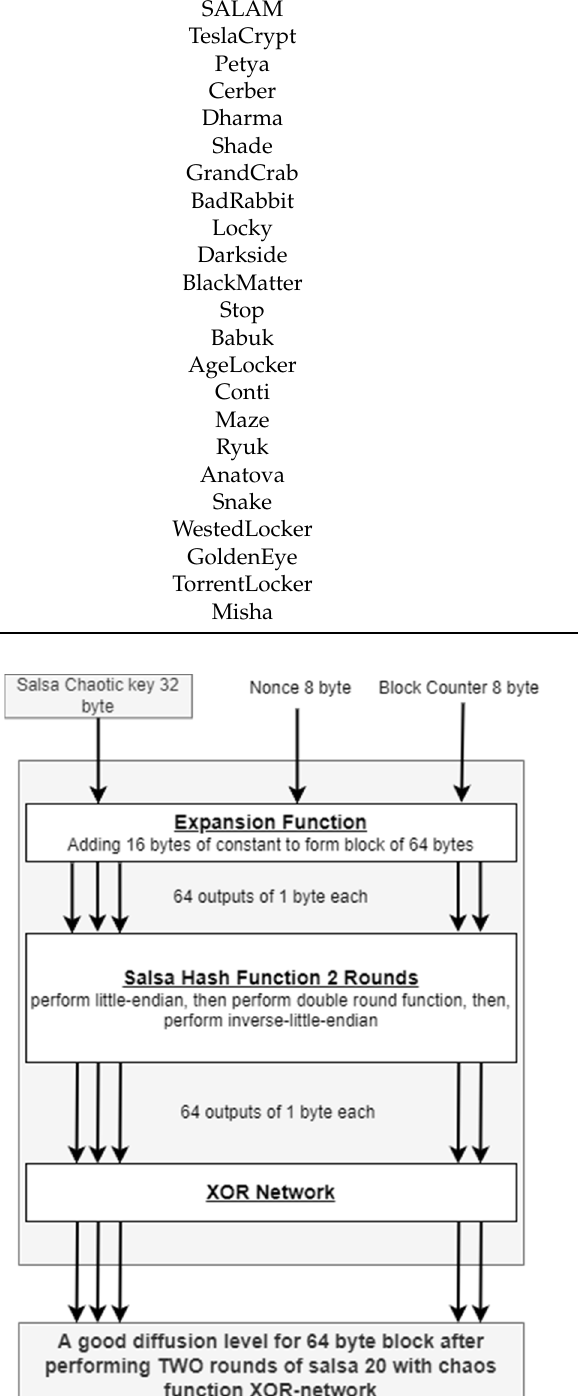
Figure 4. Salsa20 Block Diagram. Adapted with permission from Ref. [27]. Table 5. Ransomware Encryption Algorithms [28–30].